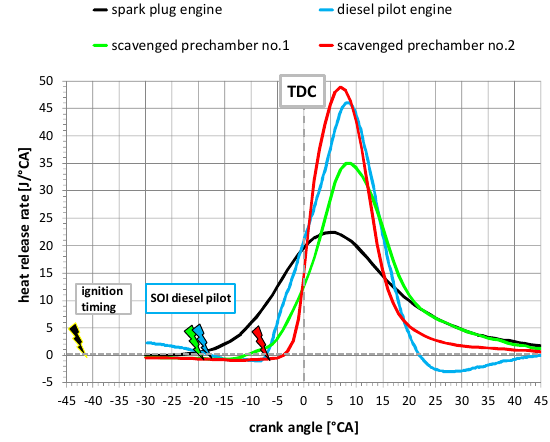
Fig. 25. Net heat release rates for operating point 1500 rpm/100 Nm and λ =